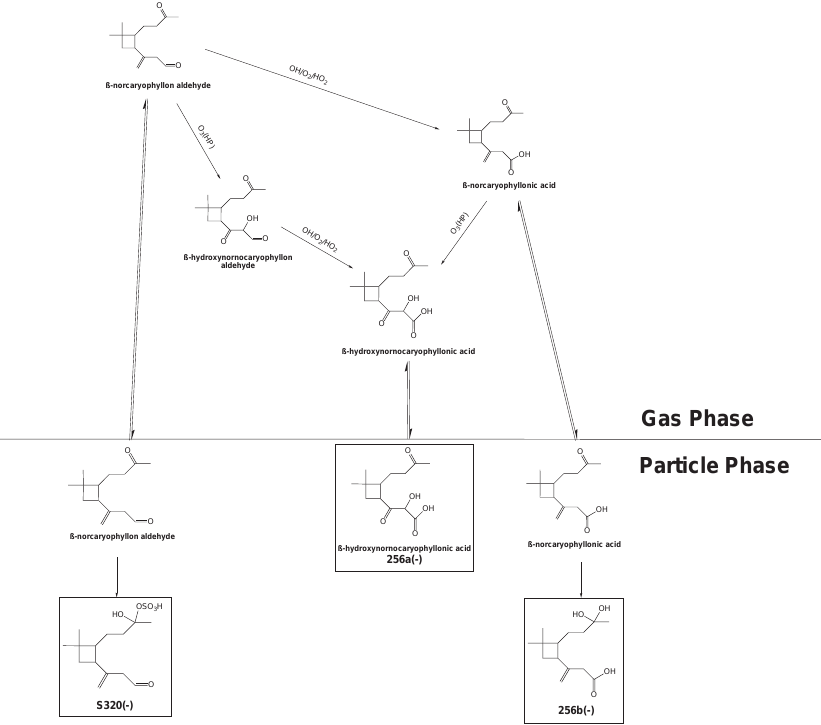
Scheme 5. Proposed reaction pathways of β -norcaryophyllon aldehyde, leading to compounds detected by ESI in the particle phase. For- mation mechanism of β -norcaryophyllon aldehyde from the ozonolysis of β -caryophyllene (Winterhalter et al., 2009). Boxes indicate compounds detected by ESI in the particle phase. One possible structural isomer is shown. HP is the hydroperoxide